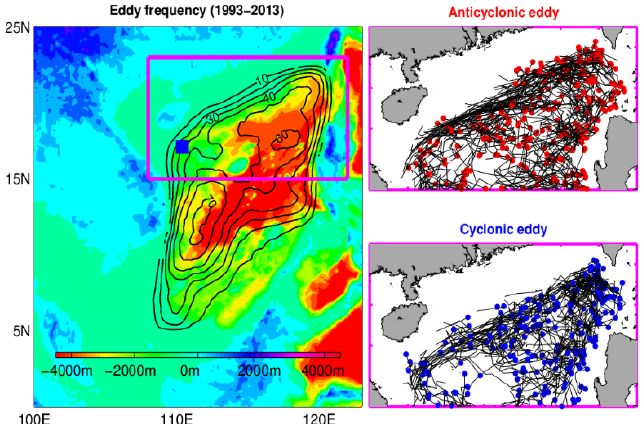
Figure 1. Statistical characteristics of mesoscale